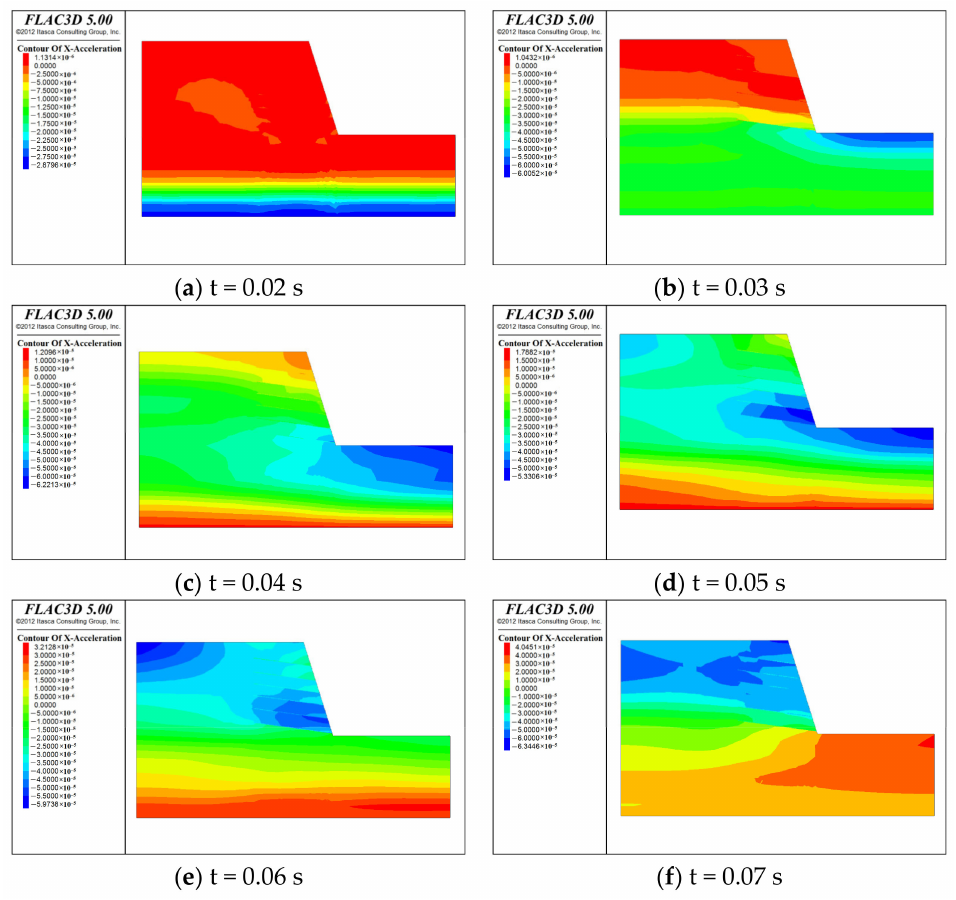
Figure 6. Wave propagation characteristics through the slope when input wave is in x -direction.